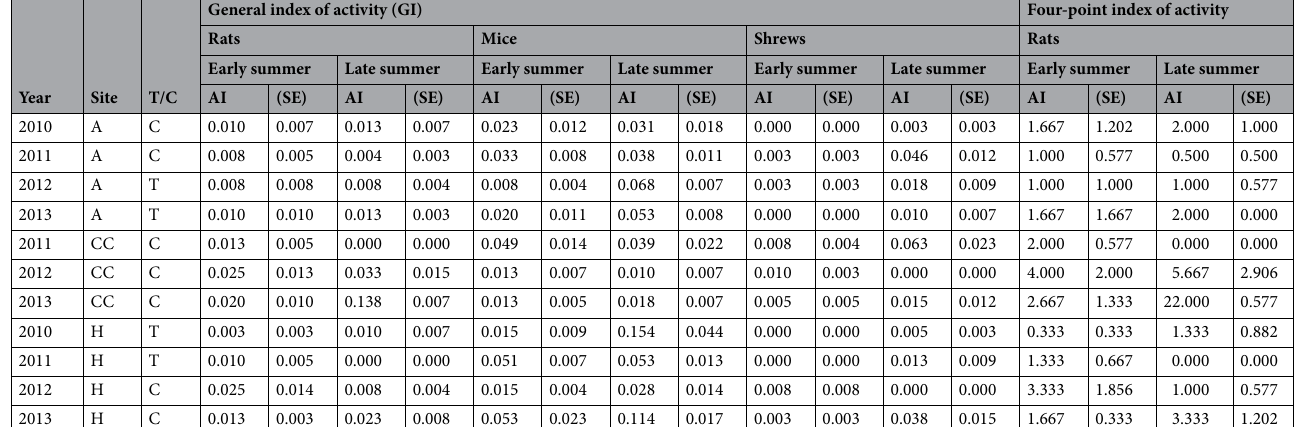
Table 1. Rodent activity indices (AI) for three study sites (Askival (A), Clough’s Crag (CC) and Hallival (H)) on the island of Rum between 2010 and 2013. A rodenticide treatment (T) was carried out at one site each year (with the aim of controlling introduced Norway rats) while the remaining two were untreated (C).